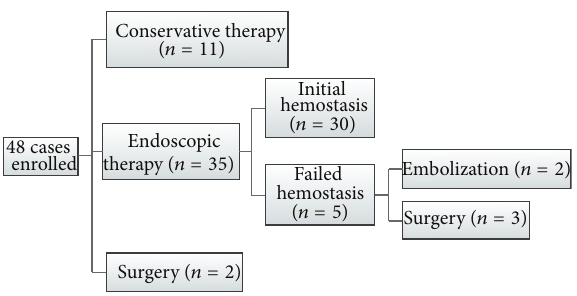
Figure 1: Flow chart of patient management and